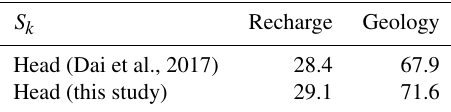
Table 3. Global first-order process sensitivity index ( S k ) for hy- draulic head calculated by the hydrology model; calculated using the algorithm described in Dai et al. (2017). Results are presented from Dai and using MAAT in this study, demonstrating the correct implementation of the algorithm in MAAT. As above, the small dif- ferences are caused by random